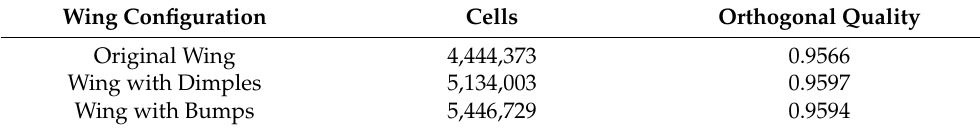
Figure 5. Mesh-independence study for the grid of the ( a ) original wing, ( b ) wing with the dimples, and ( c ) wing with the bumps. Table 3. Number of cells and orthogonal quality of the developed grids for each configuration.